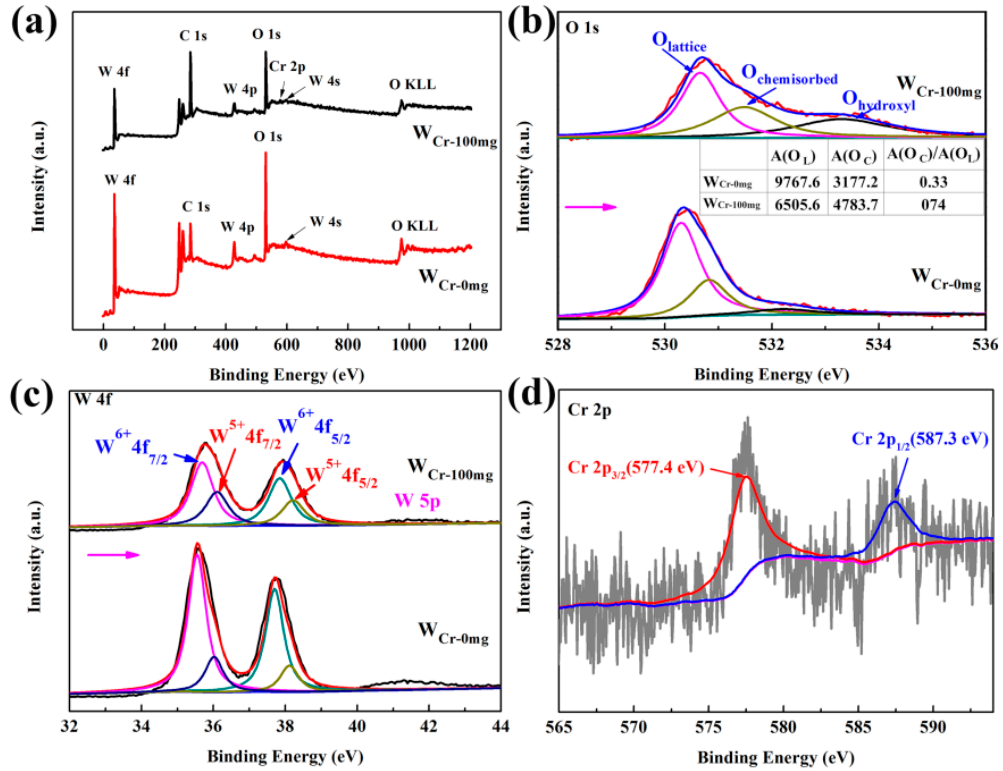
Figure 6. X-ray photoelectron spectroscopy (XPS) spectra of W Cr-0mg and W Cr-100mg : ( a ) full survey spectrum, ( b ) O 1s, (The inset table displays the values of the respective peak areas of O lattice and O chemisorbed and the proportion of O chemisorbed / O lattice in pure and Cr-doped WO 3 ). ( c ) W 4f, ( d ) Cr 2p.